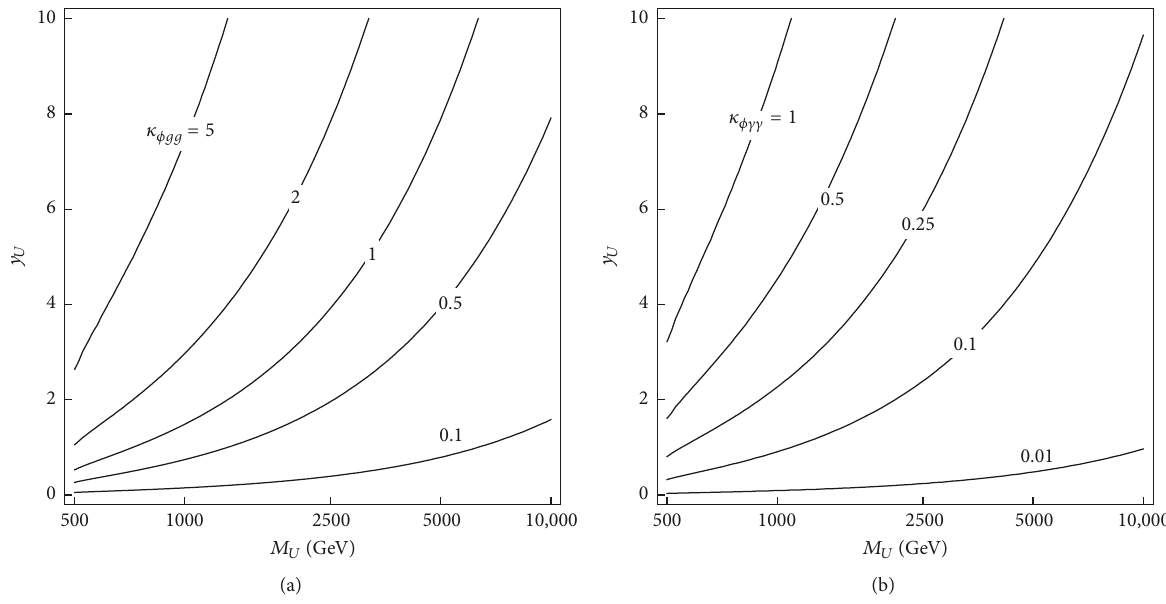
Figure 3: 𝜅 휙푔푔 (a) and 𝜅 휙훾훾 (b) for 𝑀 휙 = 1000 GeV with 𝑀 = 1000